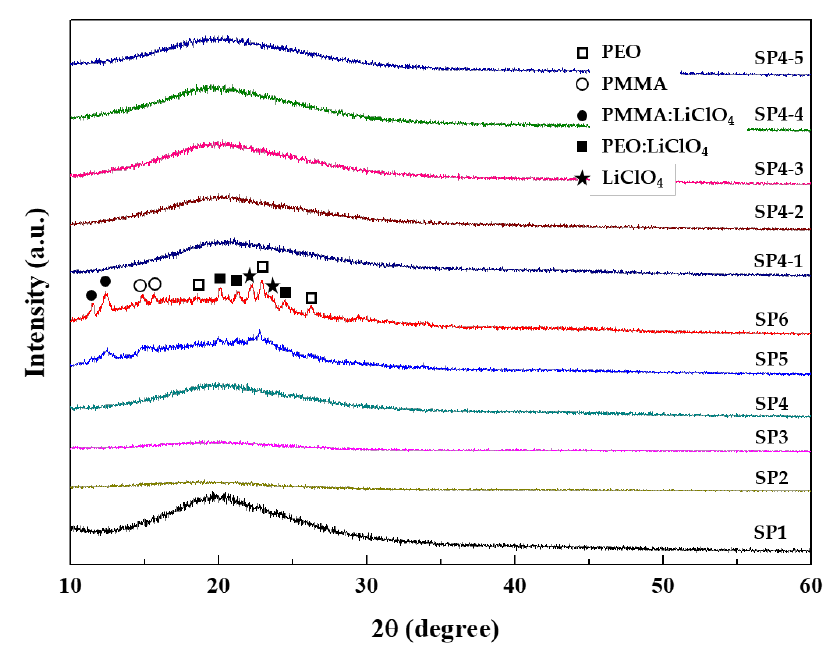
Figure 1. XRD patterns of solid polymer electrolyte samples.